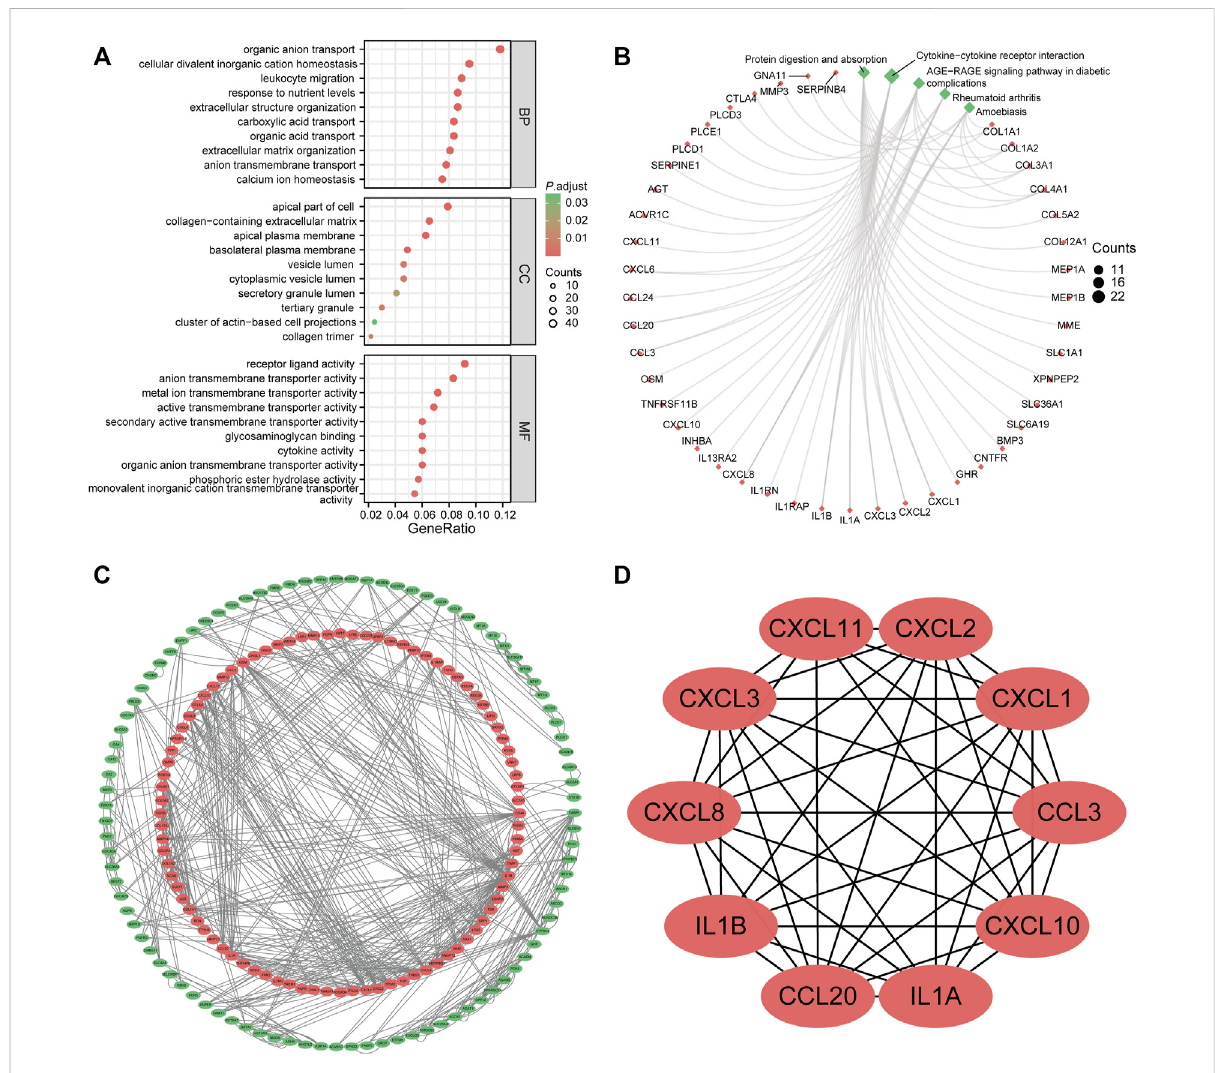
FIGURE 3 Functional enrichment analysis and protein – protein interaction (PPI) network of common differentially expressed genes (DEGs). (A) gene ontology enrichment analysis of common DEGs. (B) Kyoto Encyclopedia of Genes and Genomes enrichment analysis of common DEGs. (C) PPI network ofcommon DEGs. The red noderepresented upregulated genes; thegreen node standsfor downregulated genes. (D) hub genesidenti fi ed from the PPI network. Abbreviation: DEGs, differentially expressed genes; BP, biological process; CC, cellular components; MF, molecular function; PPI, protein – protein